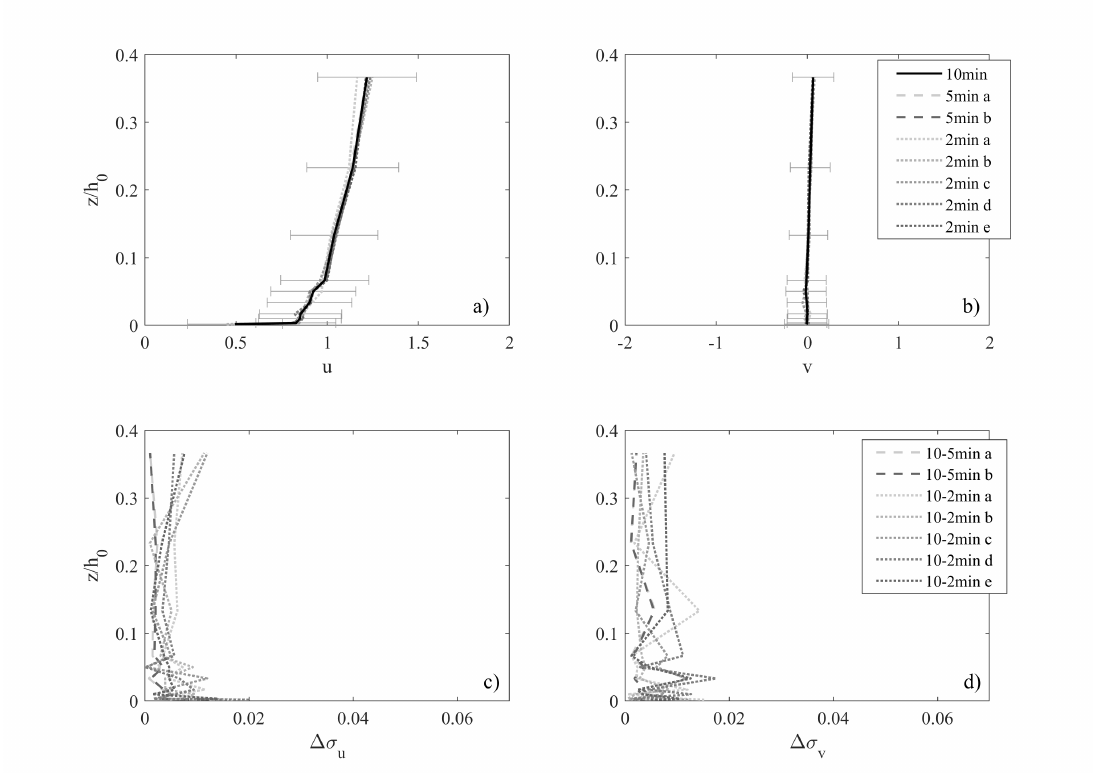
Figure 3. Mean velocity time variability for test 3 (CO, CC, U = 0.14 m/s): Dimensionless time-averaged velocity profiles with the different timespans for streamwise ( a ) and crosswise ( b ) velocities, standard deviation differences from the 10 min timespan expressed as a fraction of U for streamwise ( c ) and crosswise ( d )